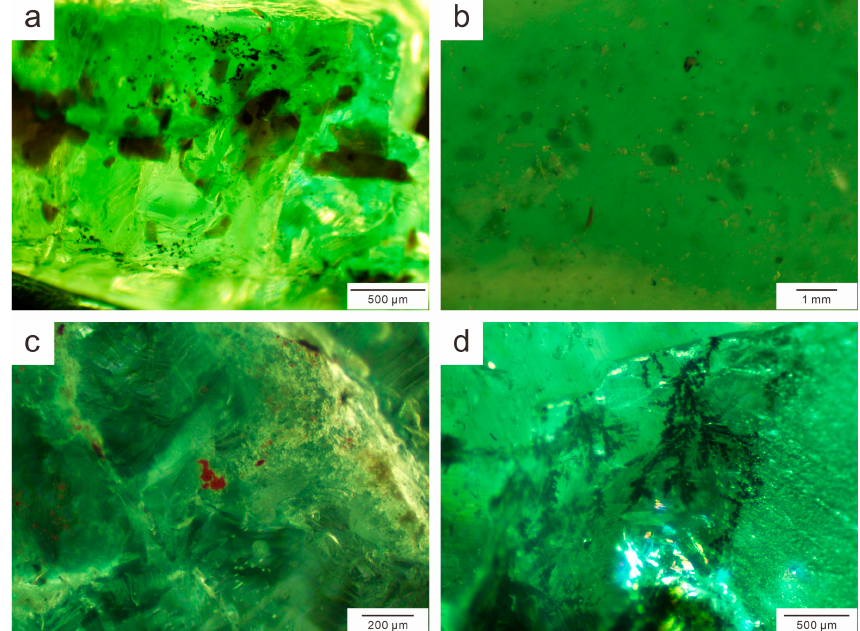
Figure 4. ( a ) Brownish platelet phlogopites and black spot oxide inclusions in emerald (KAM-6); ( b ) Pseudo-hexagonal green platelet phlogopites in emerald (KAM-88); ( c ) An irregularly shaped platelet hematite in emerald (KAM-42); ( d ) Black dendritic oxide inclusions in emerald (KAM-15).